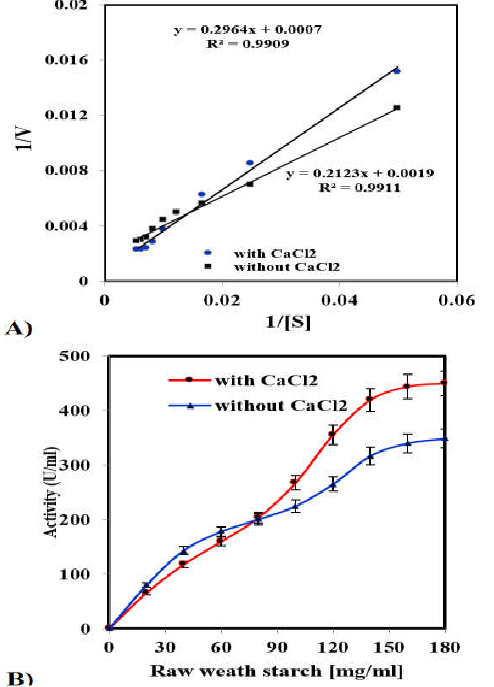
Fig. 7. Effect of Ca 2+ (5 mM) on the enzymatic degradation of different concentrations of raw wheat starch (20-180 mg/ml) as substrate, after 6 h at 45 °C. In each of two states, with or without Ca 2+ , K Vmax values were found from Line weaver–Burke and Michaelis-Menten